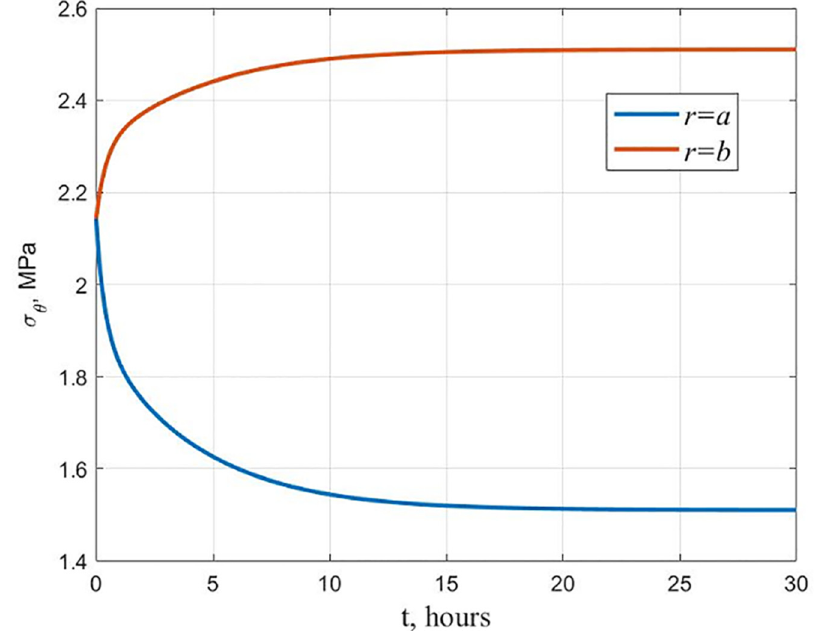
Figure 7. Change in time of stresses σ θ at the inner and outer surfaces of a cylinder equally stressed at the initial moment of time.